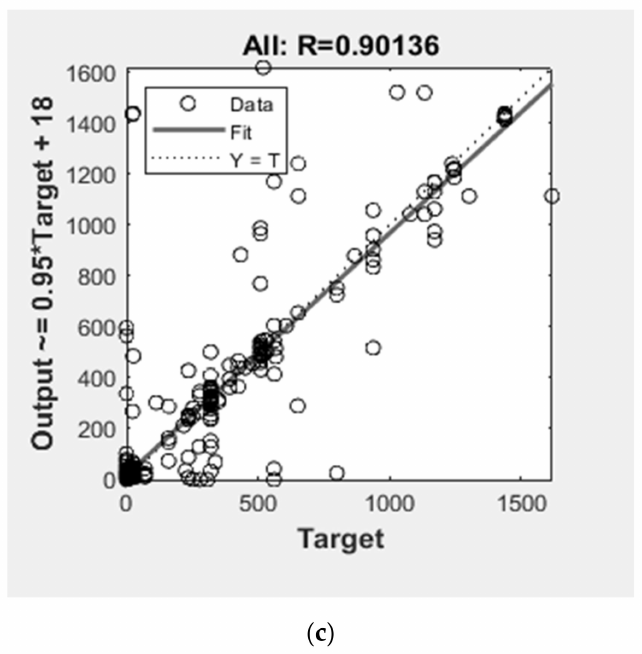
Figure 3. Training performances of ANN [2:16:16:7] model, ( a ) nest validation performance; ( b ) train- ing state; ( c )